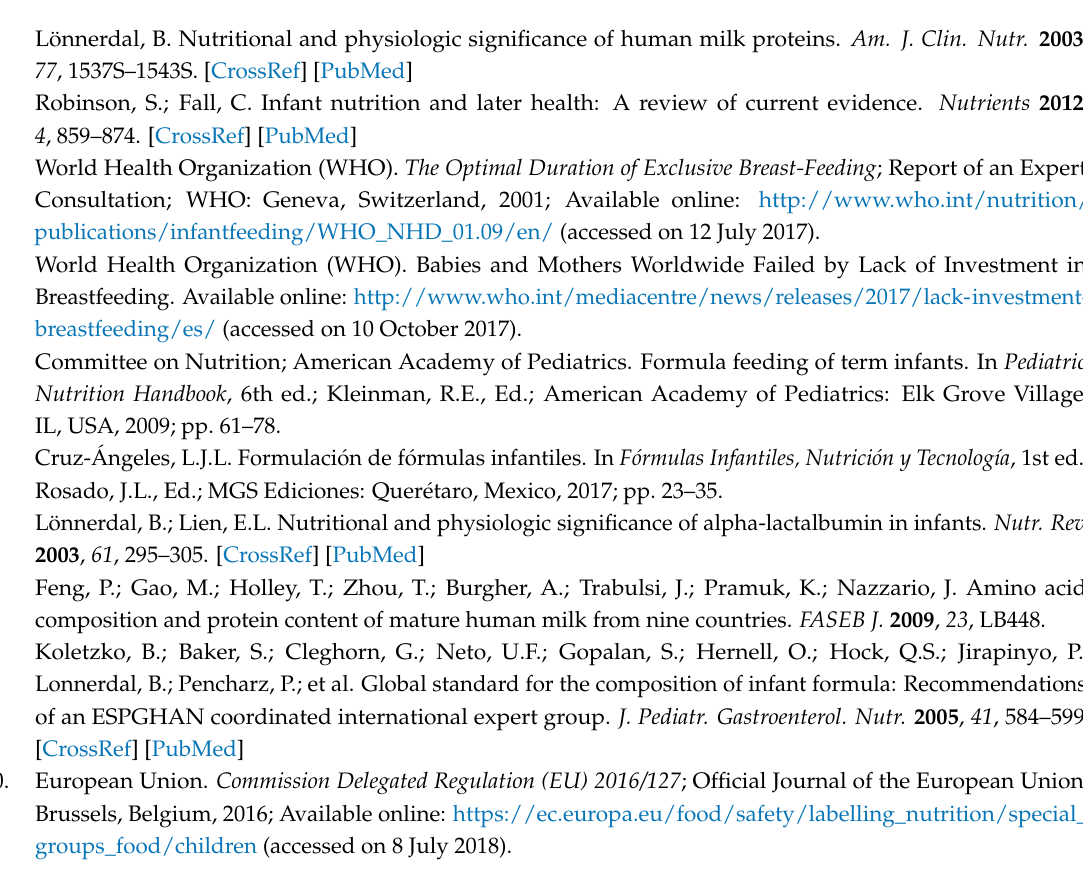
Table S1: CONSORT 2010 checklist of information to include when reporting a randomised trial